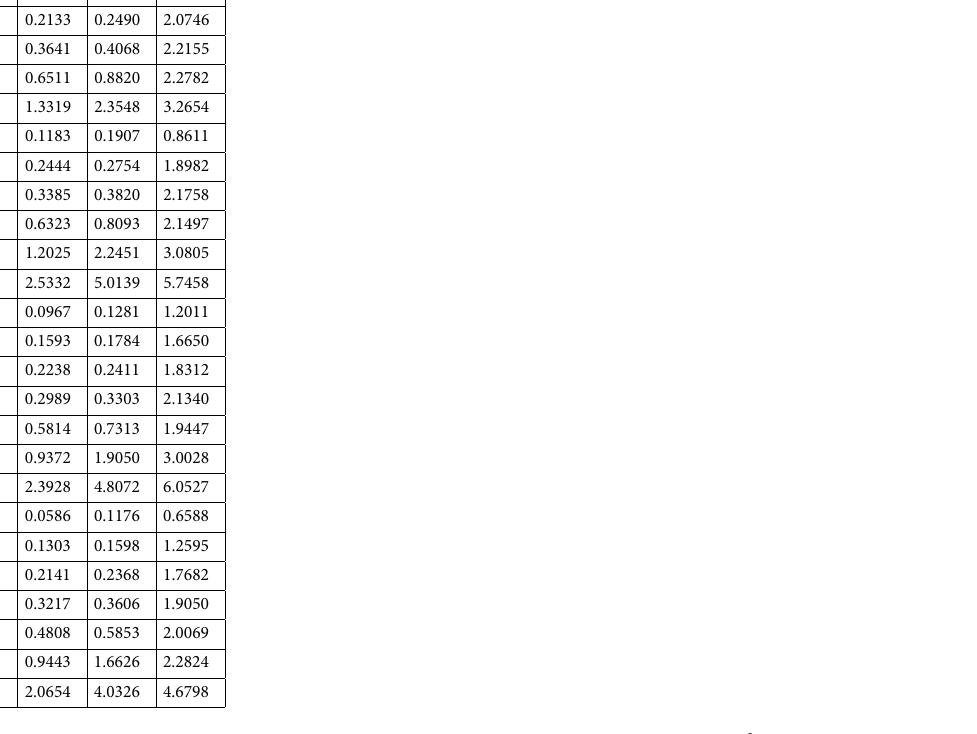
Table 8. The calculated vapor quality solved with Eq. (11), utilizing the density ρ (kg/m 3 ), saturated